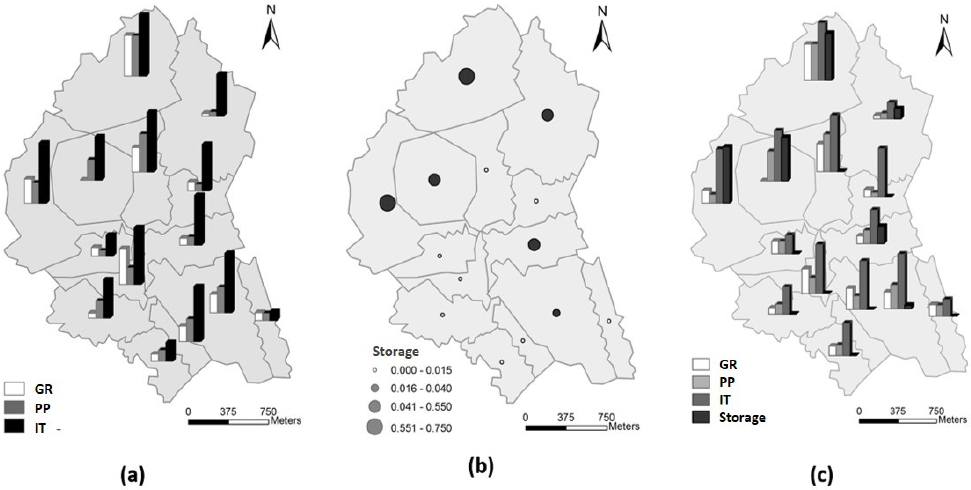
Figure 9. Spatial distribution of measures in optimized solutions for the three different approaches of drainage systems: ( a ) Decentralized, ( b ) Centralized, ( c ) Combined.